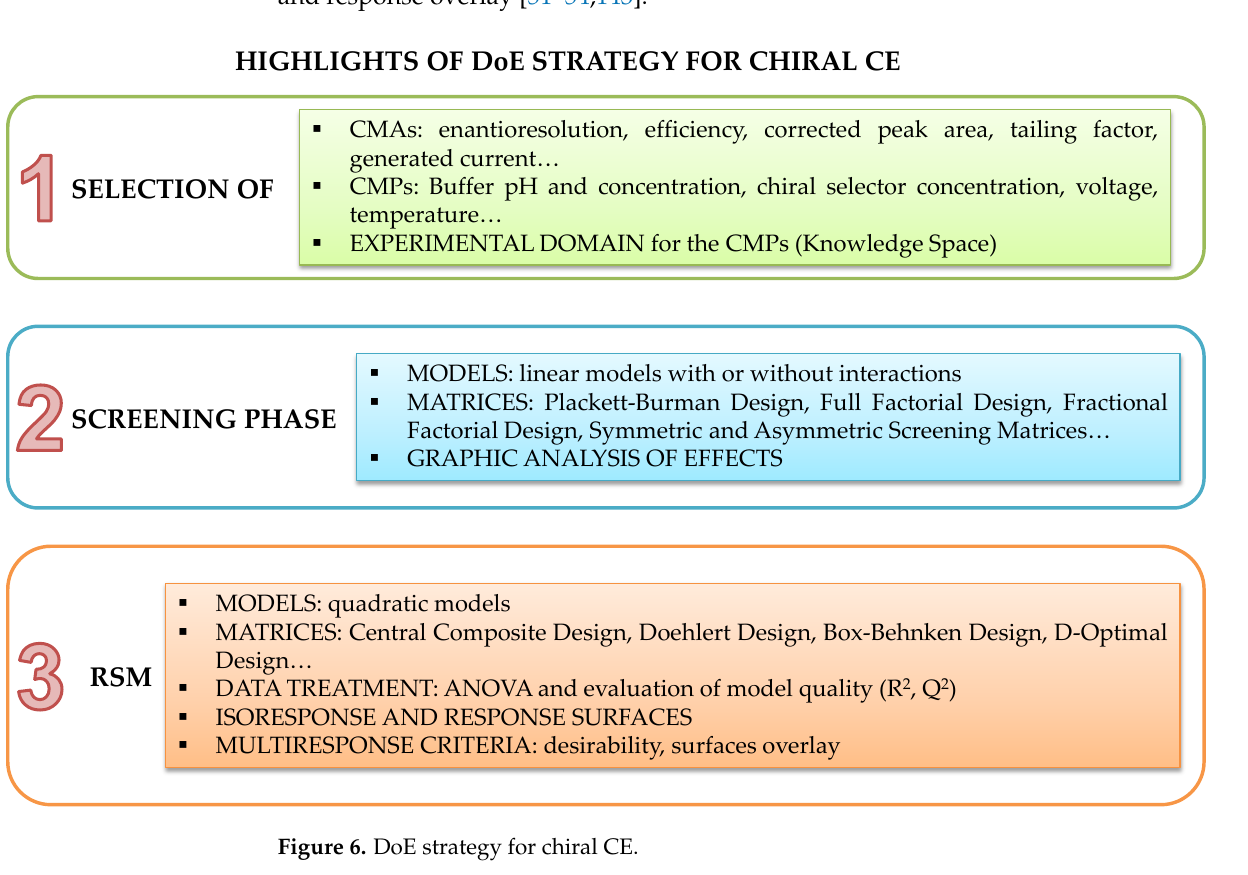
Figure 5. Ishikawa diagram for a generic CZE method. Analytical procedure parameters: C — con- trolled factor, N — noise facto, and X — experimented factor.